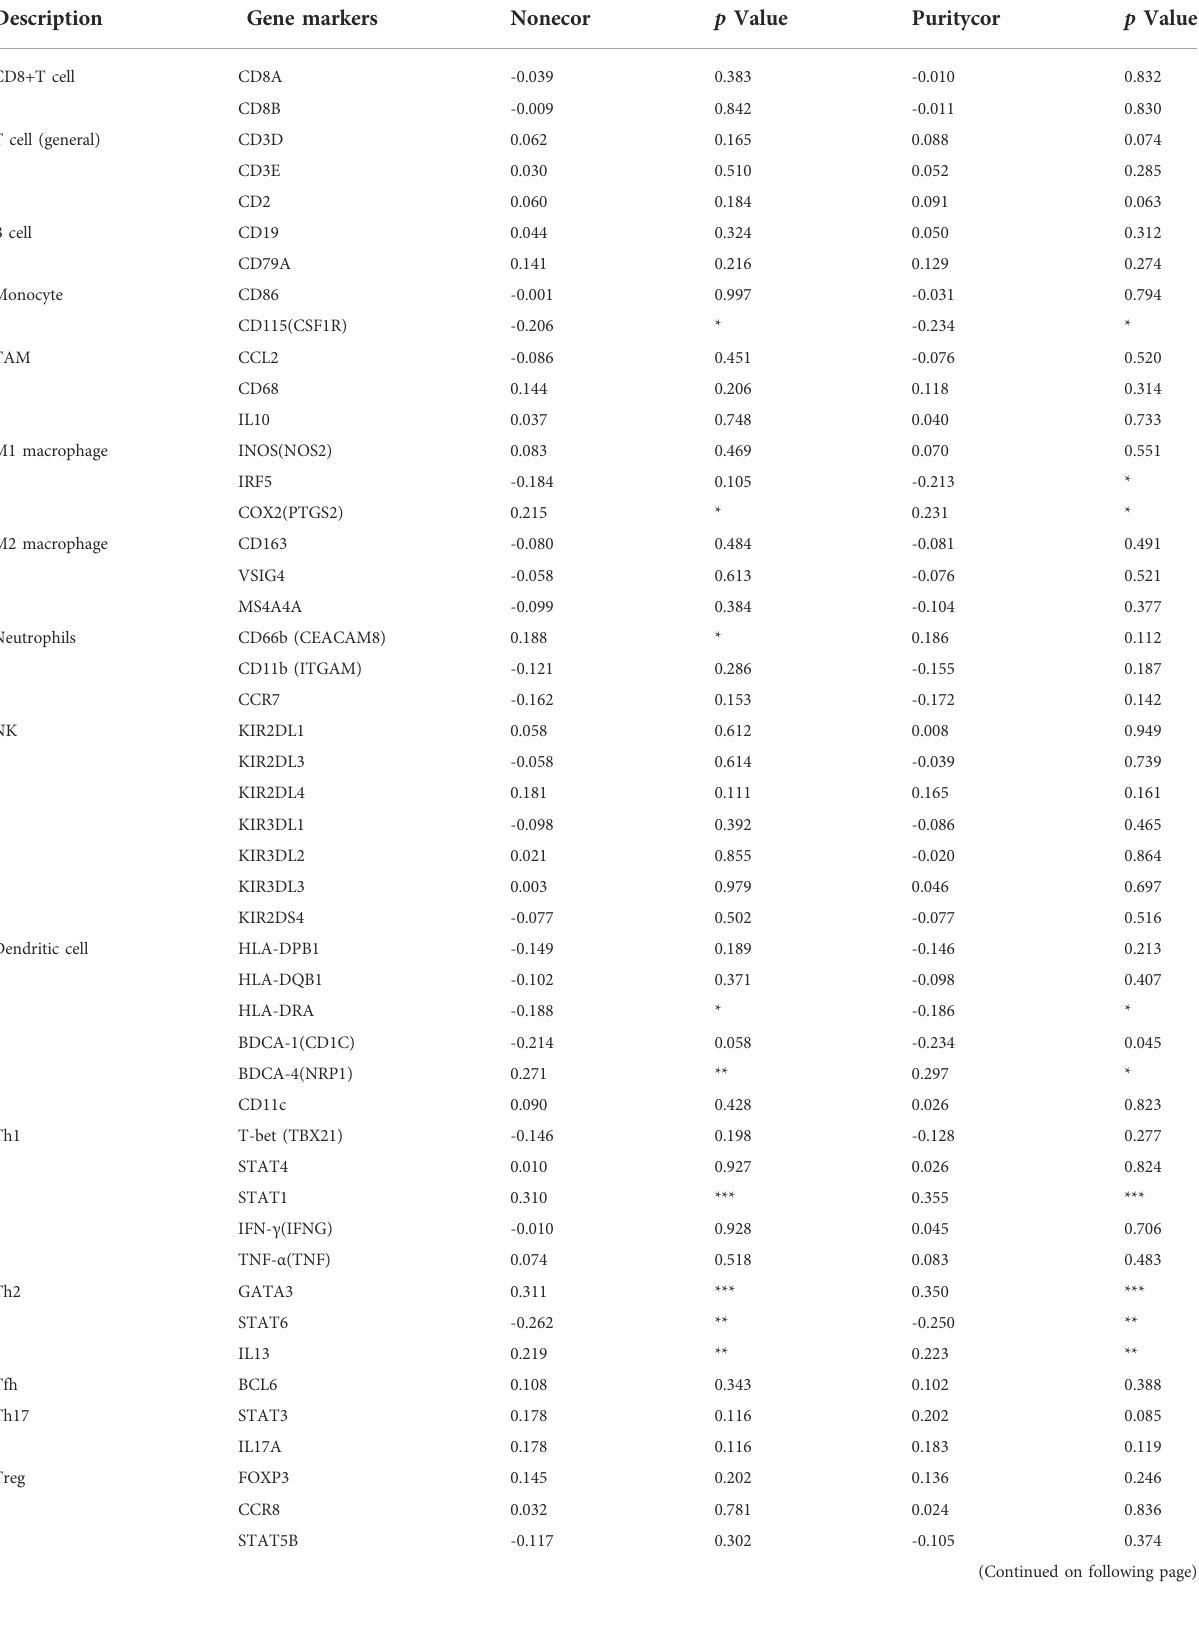
TABLE 4 The correlations between TK1 and gene markers of immune cells in PCa and normal cells by